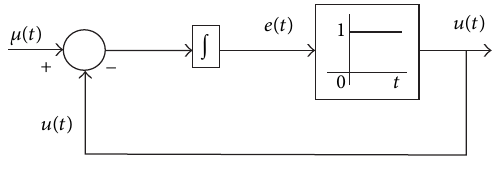
Figure 14: First order Σ - Δ